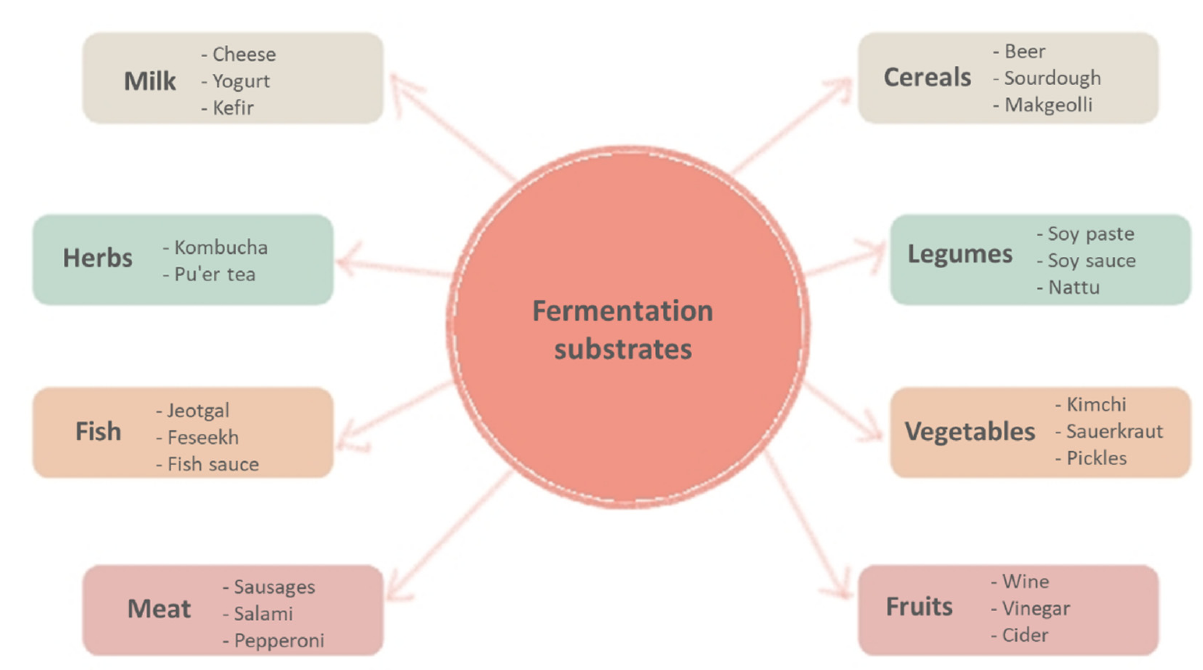
Figure 1. Common fermentation substrates and produced fermented foods and beverages.